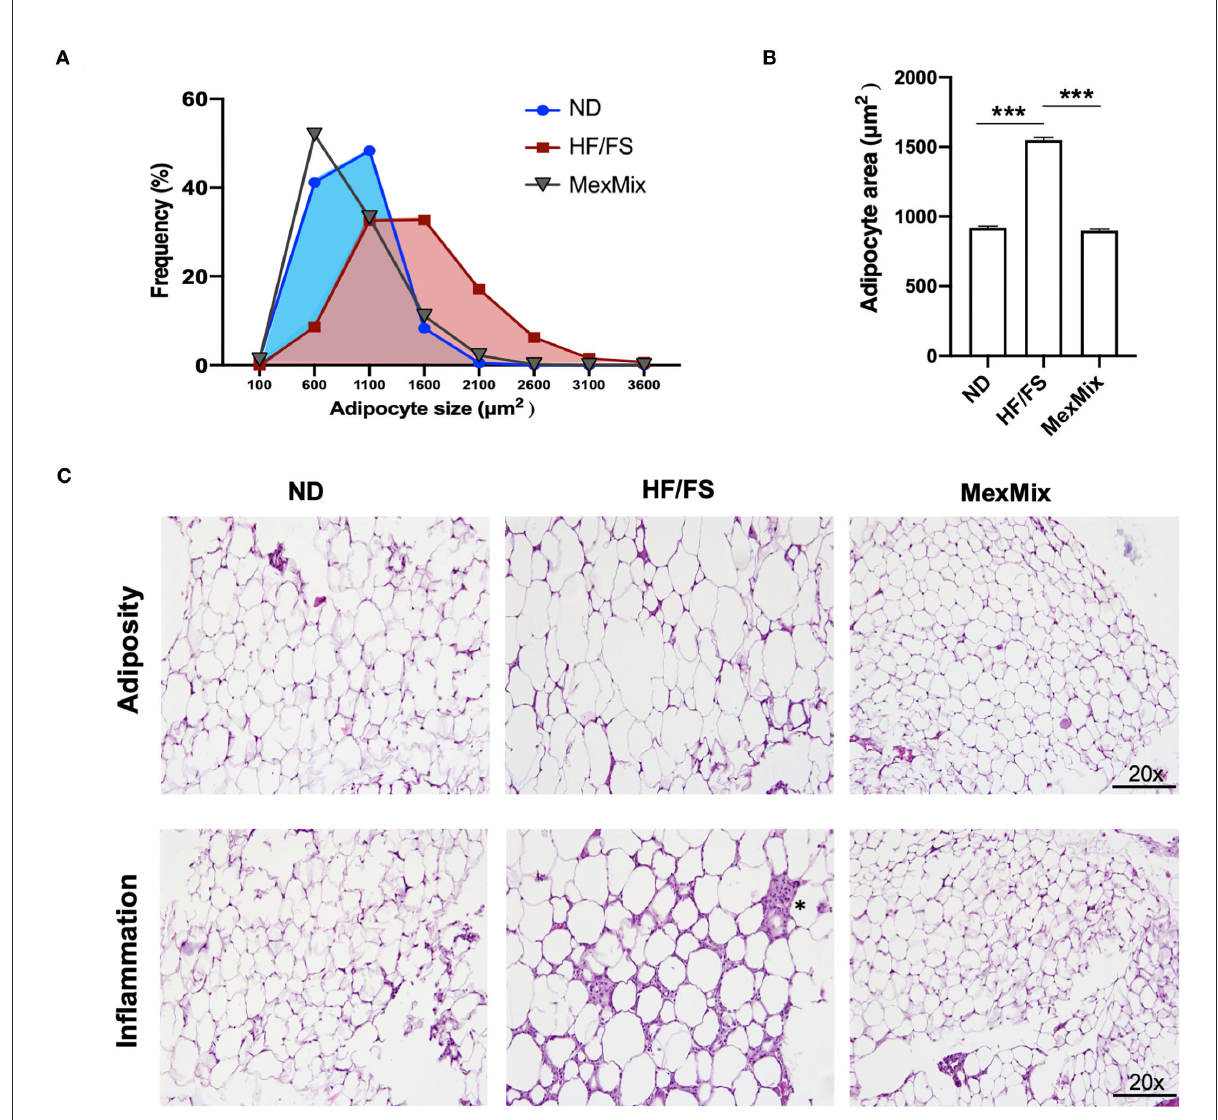
FIGURE4 Effect of the MexMix diet on adipocyte size. (A) Frequency of adipocyte size. (B) Mean adipocyte area. (C) Hematoxylin and eosin staining [adipocyte area and inflammatory infiltrate (*)]. Data represent mean ± SEM (*** p <